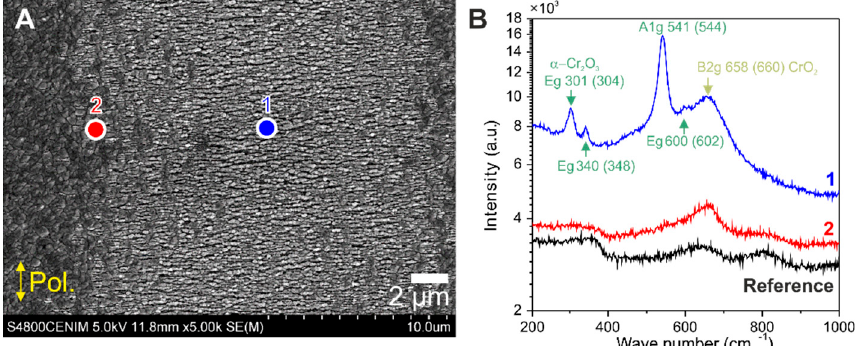
Figure 7. ( A ) Top-view SEM micrograph taken at 5 kV of an irradiated line on the CrN surface using the Yb-doped fiber laser system. The whitish regions indicate that the laser-processing generates LSFL ║ visible in the borders of the line (red dot) parallel to the beam polarization and HSFL in the center (blue dot) perpendicular to the laser beam polarization (indicated by the yellow double-arrows). Irradiation conditions are the same as those of Figure 4B. ( B ) µ-Raman spectra acquired at the positions indicated by the red and blue dots in ( A ) with an additional spectrum that corresponds to a non-irradiated area (black line—dot not shown in ( A ) for comparison. Note the logarithmic scale for the intensity axis.